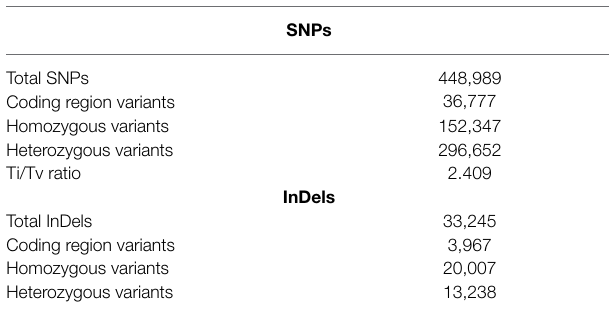
TABLE 3 | Summary statistics of various identified structural variations in JBT 36/14 compared to reference genome Oryza sativa ssp. indica 93-11.